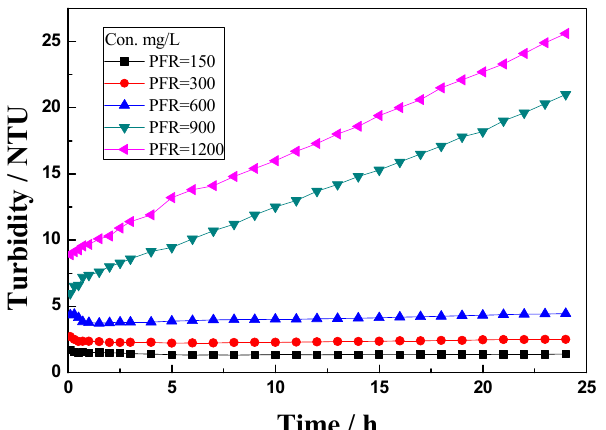
Figure 5. Effect of concentration on the turbidity of PFR solution prepared with simulated injection water at 25 °C .